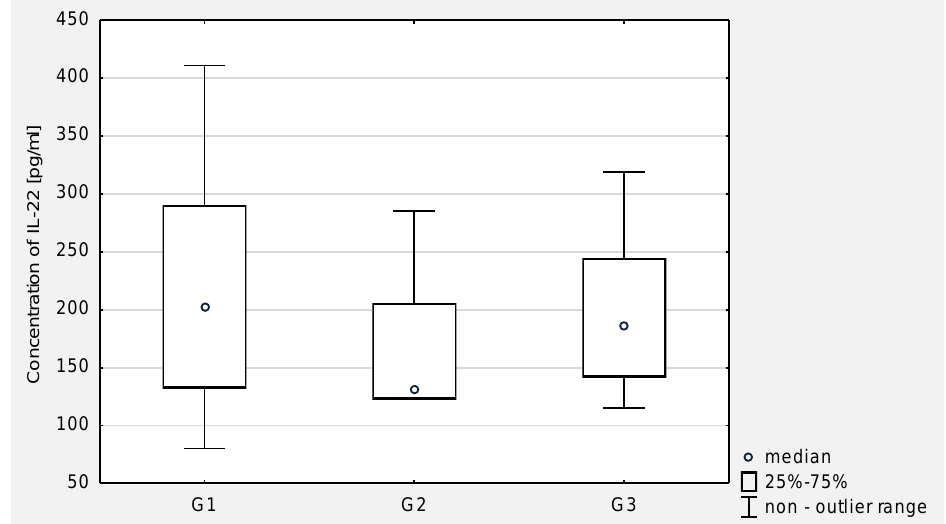
Figure 6. The concentration of IL-22 in the peritoneal fluid in women with ovarian cancer in relation to on the degree of differentiation G1 (well differentiated), G2 (moderately differentiated), G3 (poorly differentiated).